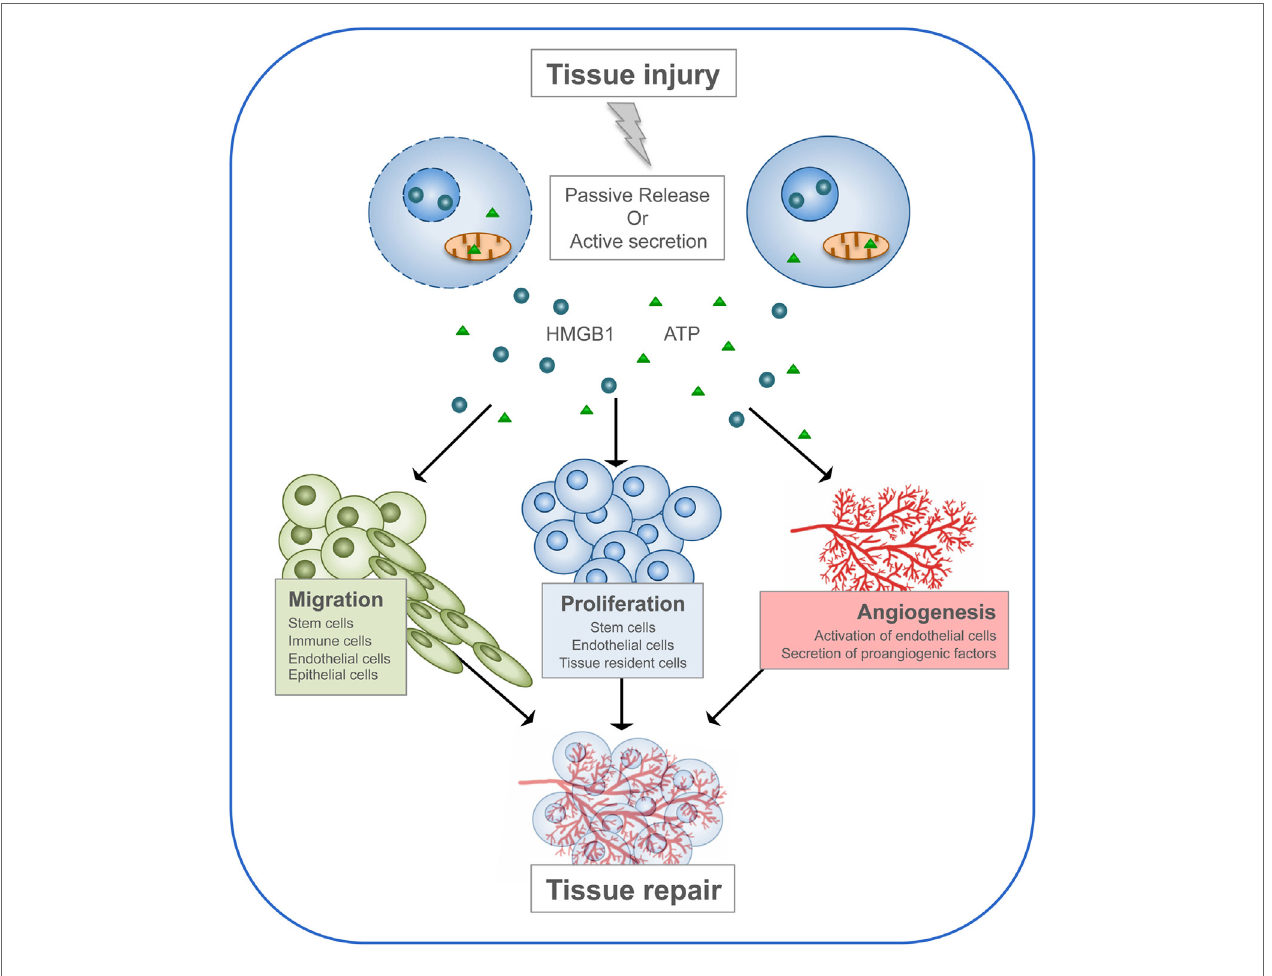
wound by engulfing dead cells and cellular debris. Then, stem cells and neighboring cells are induced to proliferate and build new tissue, together with its extracellular matrix. Endothelial cells are activated to form new blood